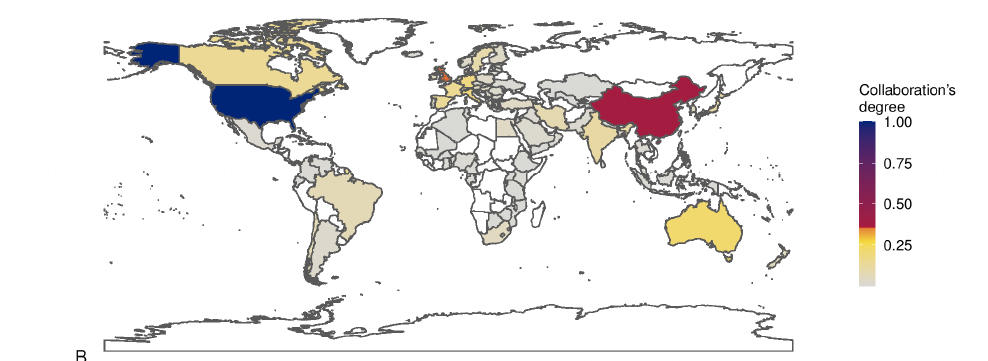
Figure 1. Panel ( A ): The plot shows the country collaboration network based on Scopus data. The vertex size is proportional to the number of collaborations, and the networks of the three most connected countries are highlighted. Panel ( B ): Spatial visualization of the degree of collaboration; blue and red colors correspond to the countries with more collaborations.